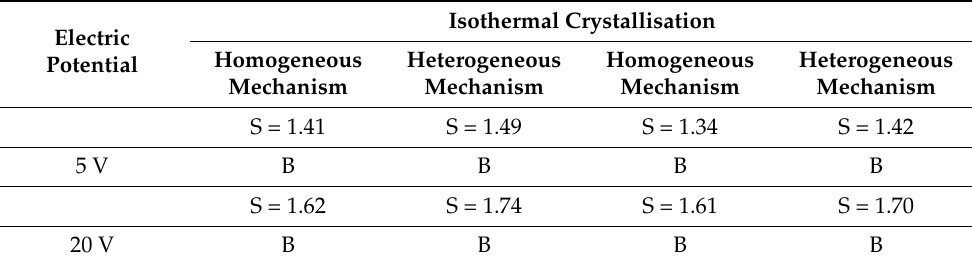
Table 4. Polymorphs of L-isoleucine grown from the isothermal crystallisation experiments.